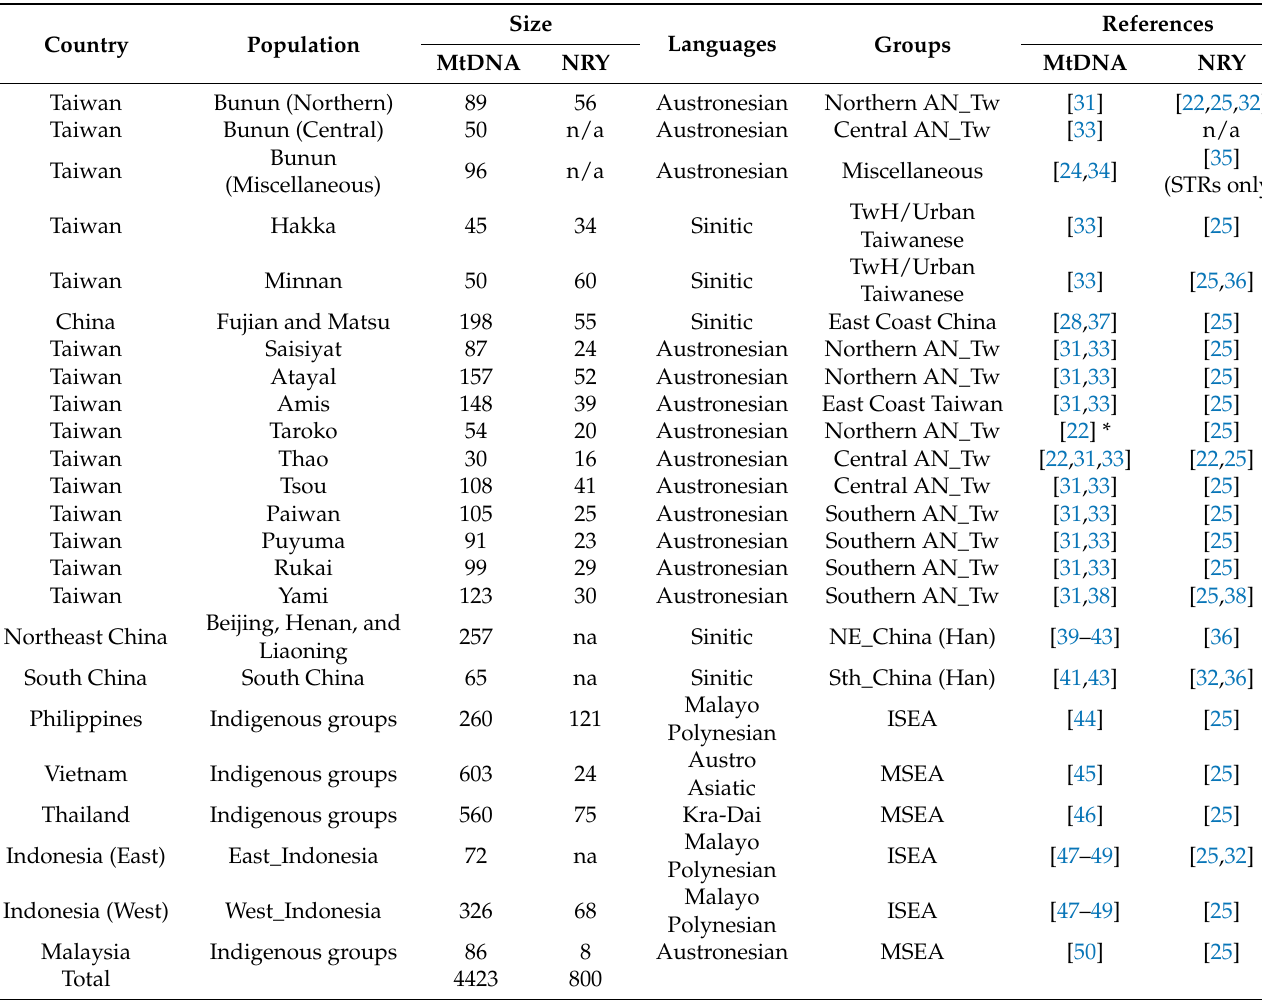
Table 1. Population